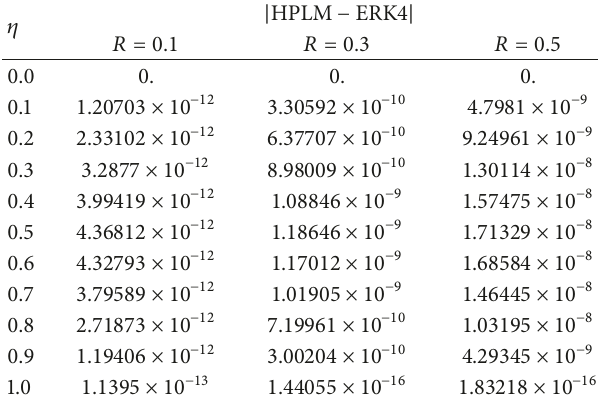
Table 6: Comparison of HPLM and ERK4